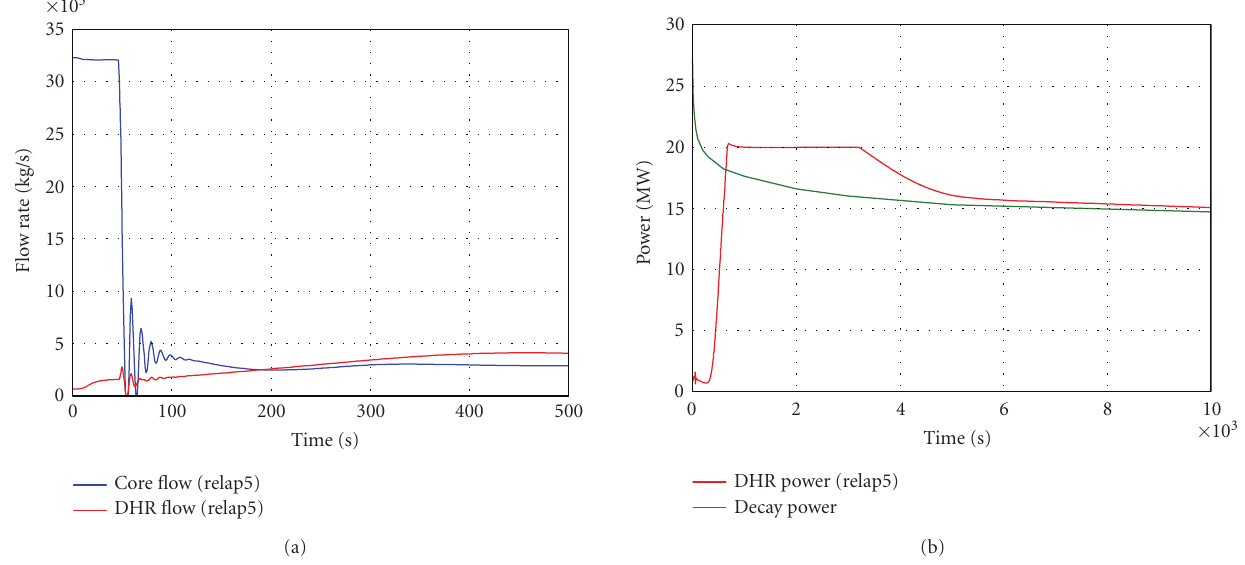
Figure 7: Lead mass flow rates (core and DHR) and heat removal in the DHR system (3 units).